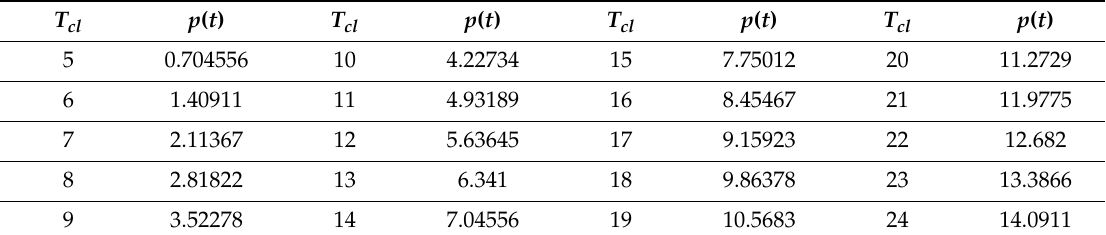
Table 9. Estimated values of p ( t ) = d accordance with Equation